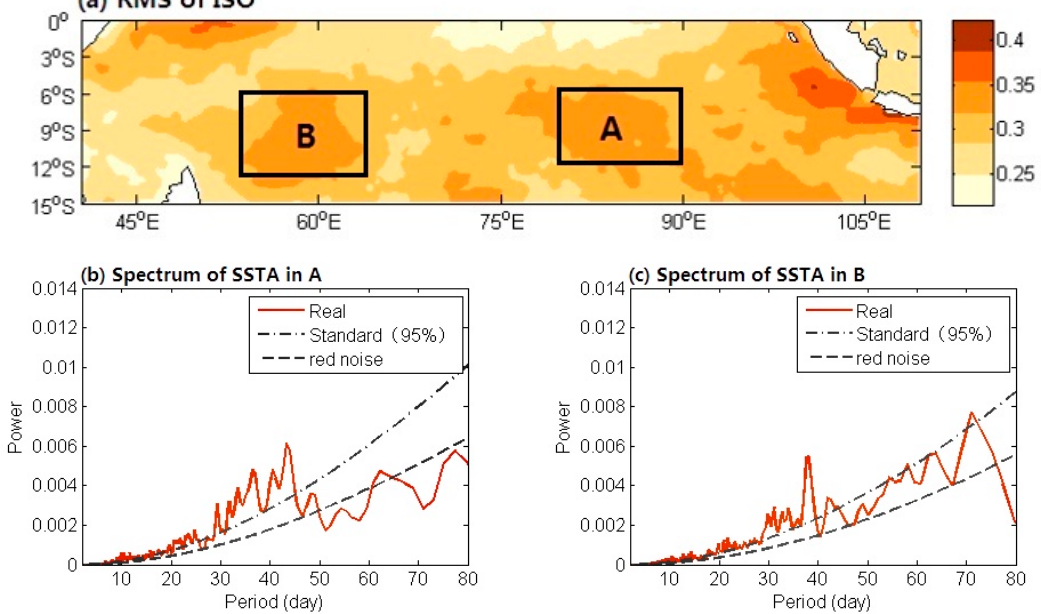
Figure 1. ( a ) RMS variance distribution of 30 – 90-day band-passed SST (°C) during 1982 – 2016. Boxes A and B indicate location of the relatively significant signal over the open ocean. Power spectra of SSTA averaged in: ( b ) Region A; and ( c ) Region B during the same period. The red-noise spectrum is computed from the lag 1 autocorrelation.